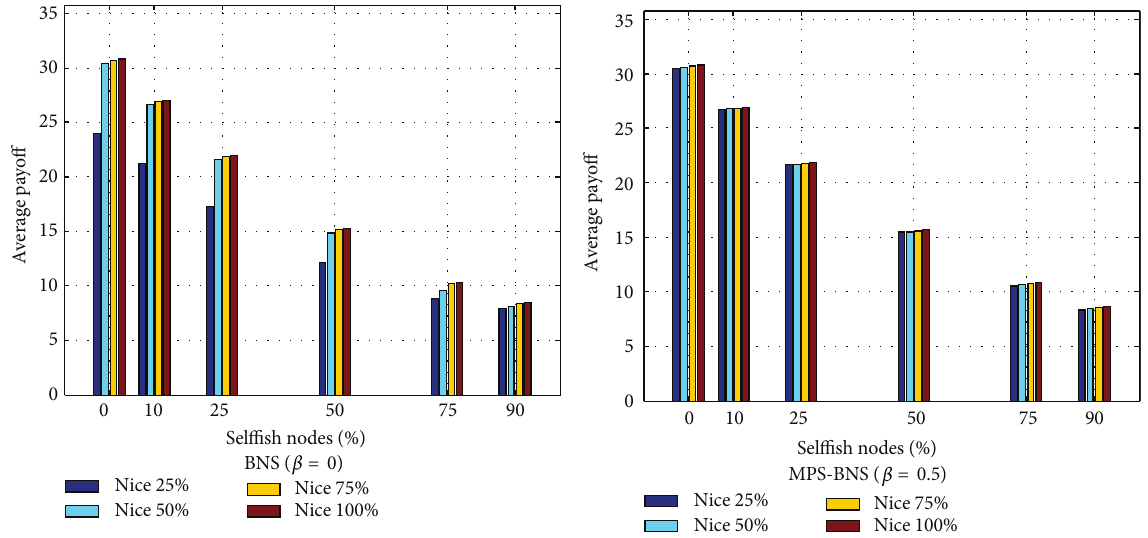
S 8: Average payoff per player of MPS-BNS with niceness against sel�sh nodes.